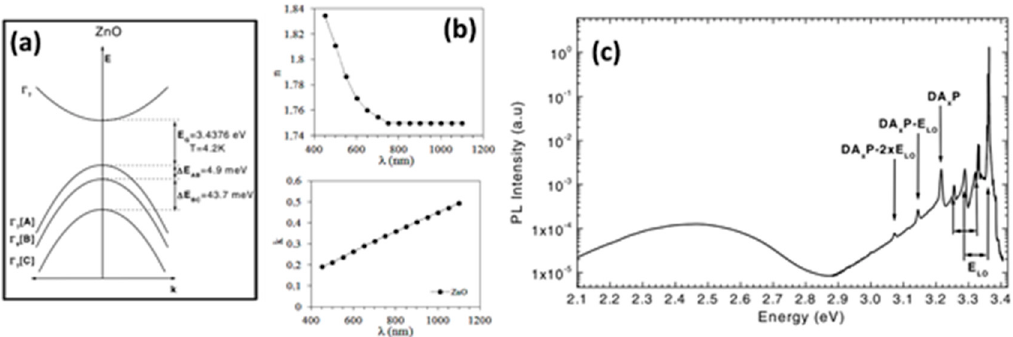
Figure 3. ( a ) Band structure splitting of the hexagonal ZnO structure caused by the crystal field and